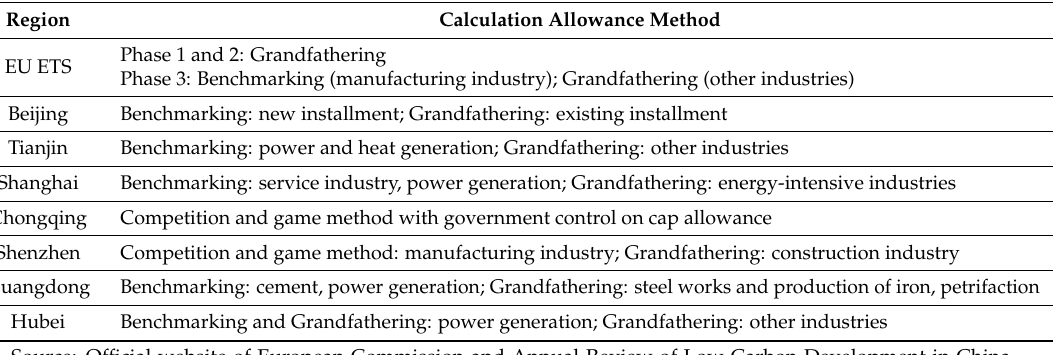
Table 6. Methods of allocating allowance in EU ETS and China’s pilot